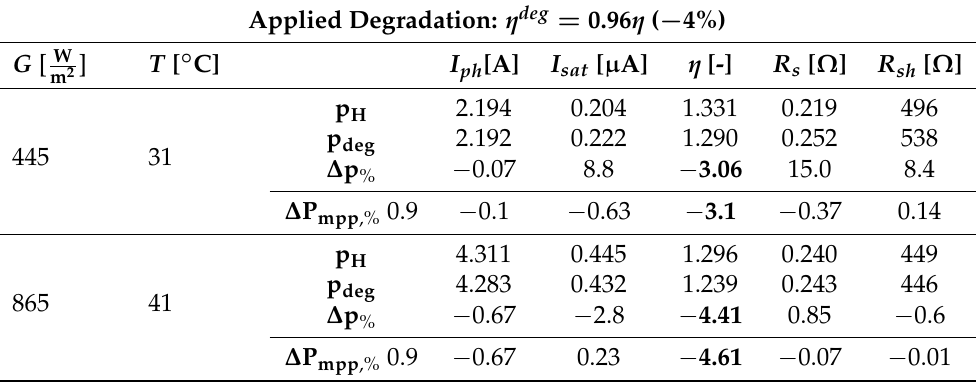
Figure 15. ANN identification of degraded curve with − 3% of variation on η for two different irradiance and temperature conditions. Table 7. SDM parameters estimated with ANN for I - V curves of Figure